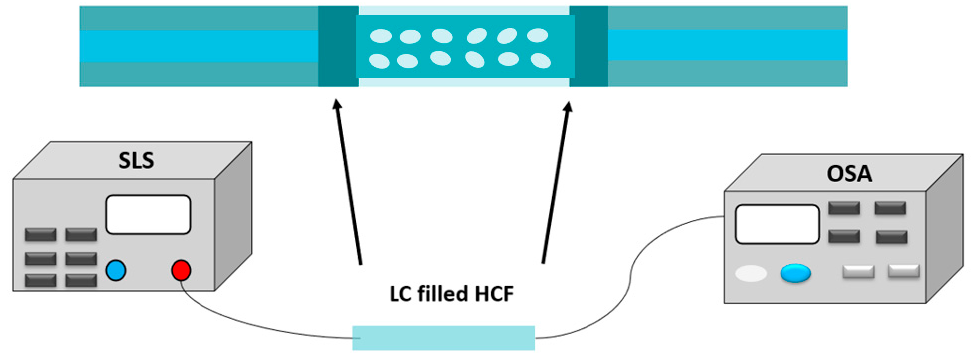
Figure 4. Schematic diagram of the pre-experimental setup. SLS: supercontinuum light source. The structure diagram of fiber optic ring temperature sensor is shown in Figure 5.